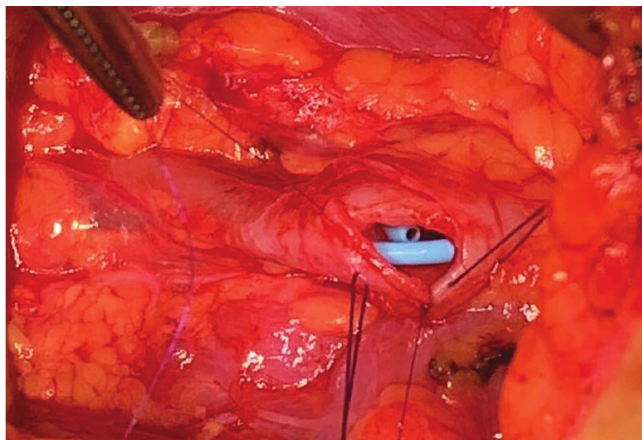
Figure 3. An anastomosis of the posterior wall between the ureter and renal pelvis.